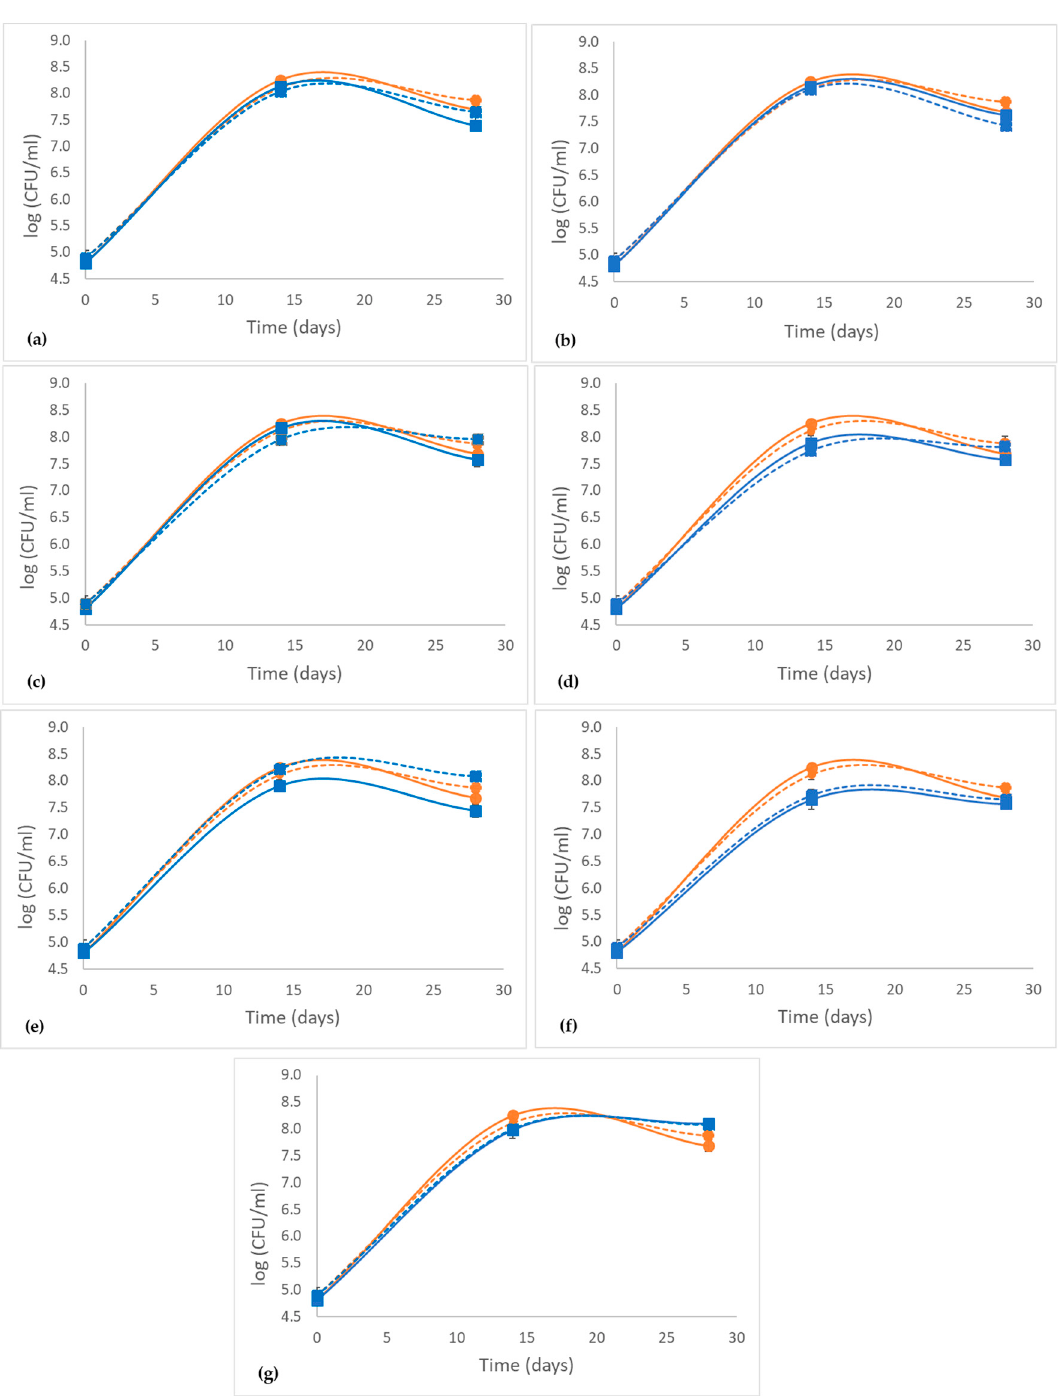
Figure 1. Bacterial concentrations (Log 10 of colony forming units) during 28 days of incubation in wine samples supplemented with phenolic compounds. ( a ) 2× Flavan-3-ols; ( b ) 2× Flavan-3-ols; ( c ) 2× Flavonols; ( d ) 3× Flavonols; ( e ) 2× hydroxycinnamic acids (HCA); ( f ) 3× HCA; ( g ) trans -resveratrol. Plane lines—non-inoculated wines; dotted lines—wines inoculated with O. oeni Oenos™. (orange)—controls; (blue)—supplemented wines. Standard deviations for three replicates.